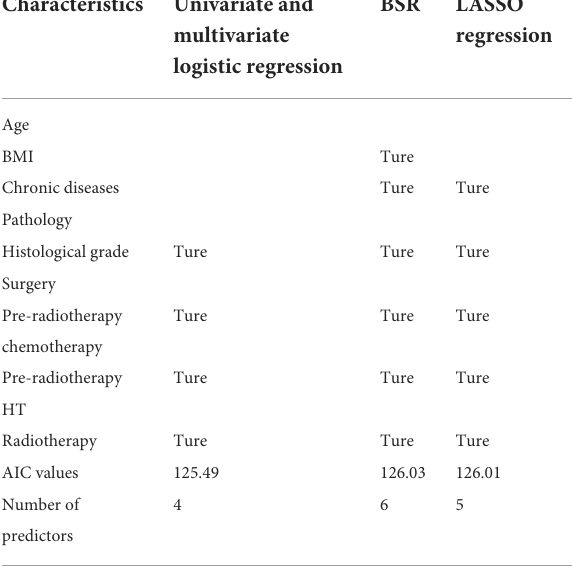
TABLE 4 Univariate and multivariate logistic regression, BSR and LASSO regression for screening predictors. Characteristics